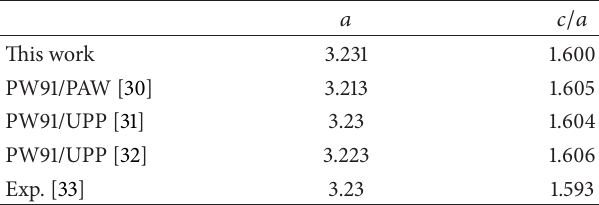
Table 1: Experimental and calculated lattice constants (˚A) for 𝛼 -Zr.